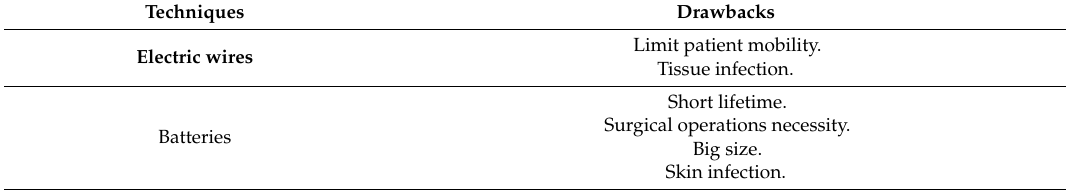
Table 1. Significant drawbacks of main existing proposed techniques to power-up implants [18]. Techniques Drawbacks Electric wires Batteries